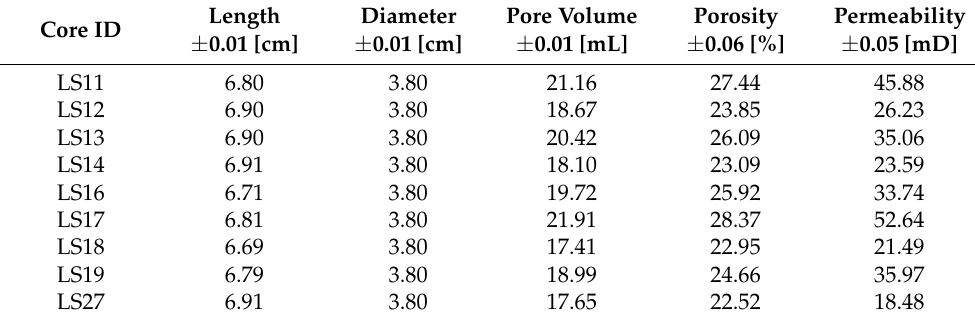
Table 1. Basic core plug